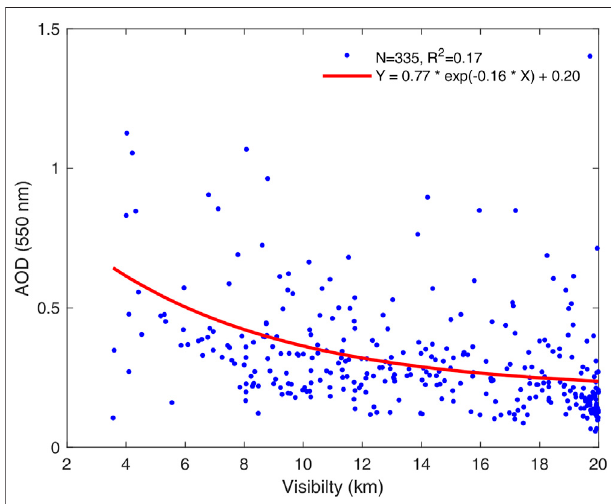
FIGURE 7 | Nonlinear regression fi t between AOD and visibility at